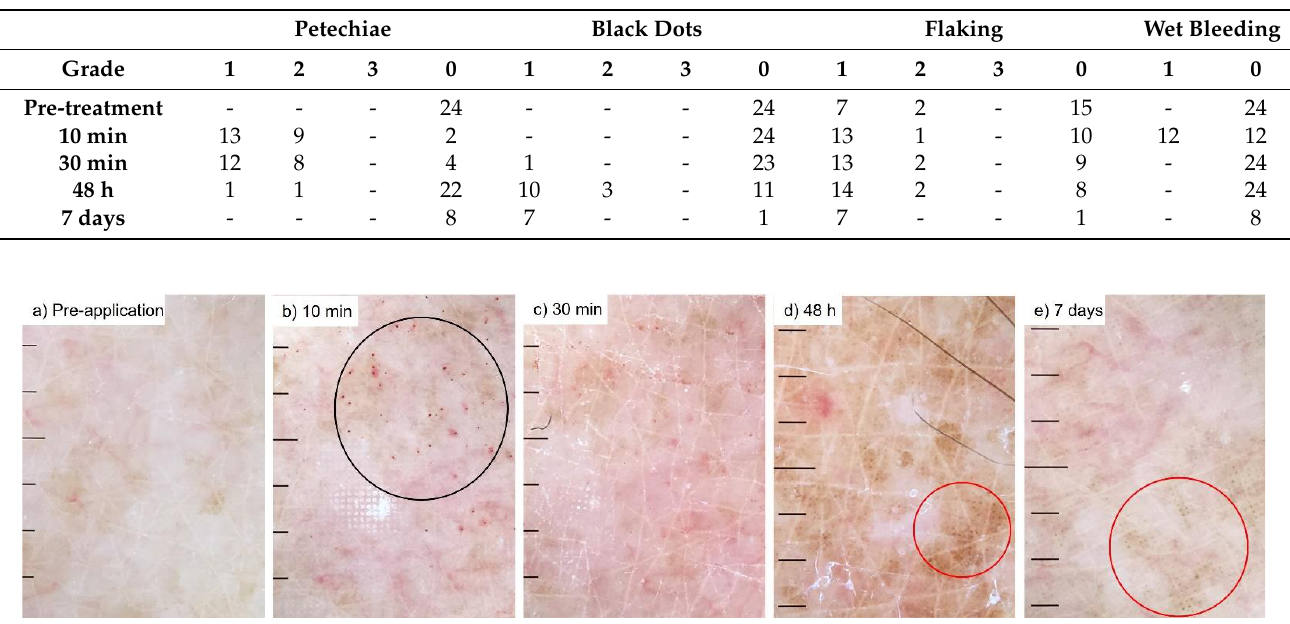
Table 1. The number of HD-MAP application sites with petechia, black dots, flaking, and minor wet-bleeding at different observations. Each individual received two HD-MAPs. Only data from 4 of the 12 volunteers were available at the 7 days follow up. Reactions grades as 1 = mild, 2 = moderate, 3 = severe, = not observed.